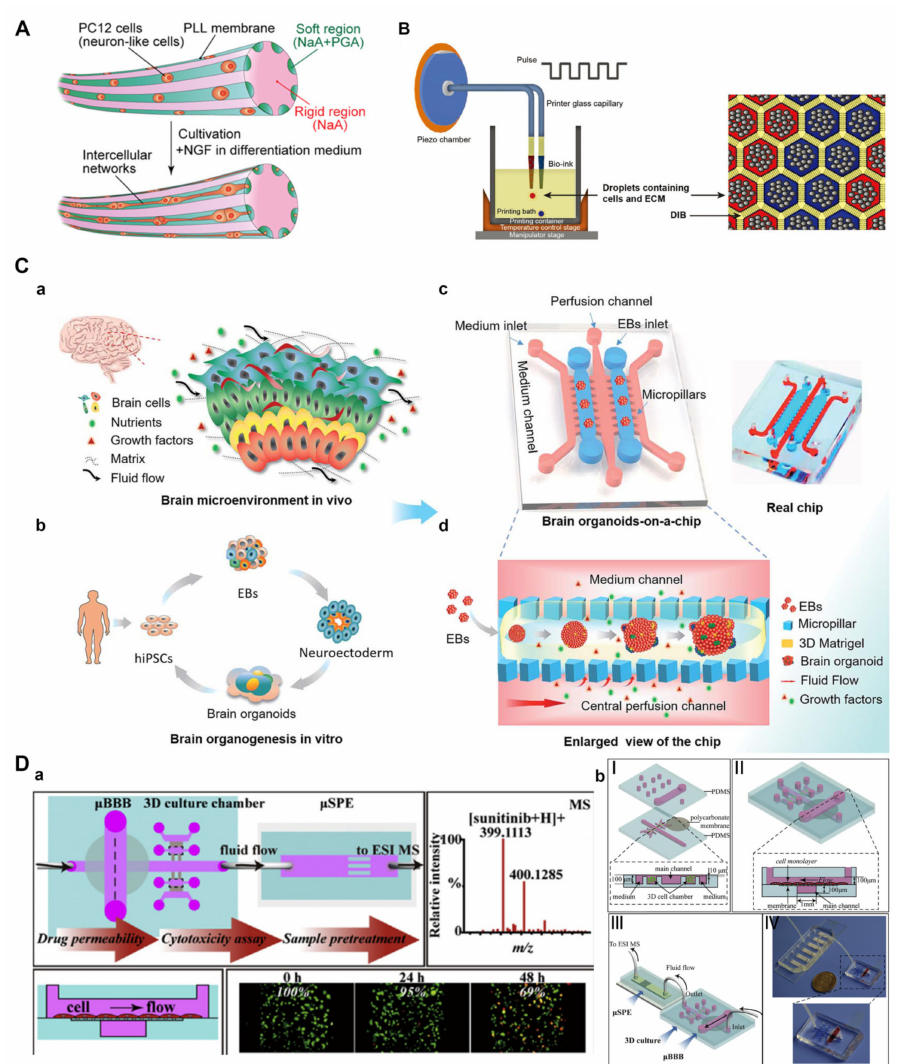
Figure 5. ( A ) Schematic of a complex hydrogel microfiber for guiding cell proliferation and forming in- tercellular networks. ( B ) The printed droplets connected by adhesive droplet interface bilayers (DIBs) using a lipid-bilayer-supported printing technique to form patterned droplet networks. ( C ) Schematic diagram of the brain organoids-on-a-chip device. The key factors of the brain microenvironment in vivo ( a ). The development process of brain organoids derived from hiPSCs in vitro ( b ). Configura- tion of the brain organoids-on-a-chip device ( c ). Enlarged view of the procedures for brain organoids generation on the chip ( d ). ( D ) A microfluidic blood–brain barrier model for evaluating drug per- meability and cytotoxicity for central nervous system drug screening ( a ). Schematic illustration of the microfluidic platform ( b ). ( A ) Adapted with permission from Ref. [99]. Copyright 2014,